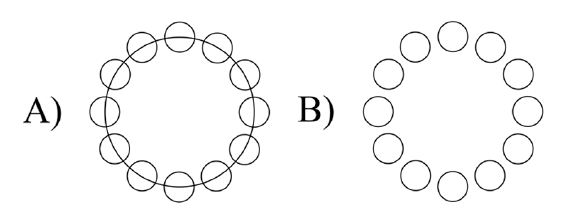
Figure 2. The Binding Ring Illusion. Which array of circles looks bigger? A ) The test stimulus used in experiment 1 or B ) The reference stimulus used in experiment